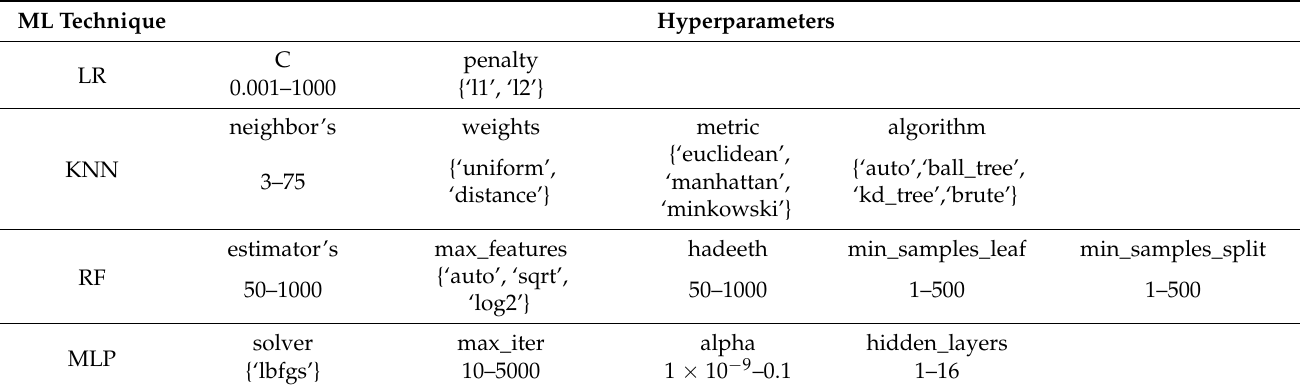
Table 1. Model hyperparameters and their ranges/possibilities for